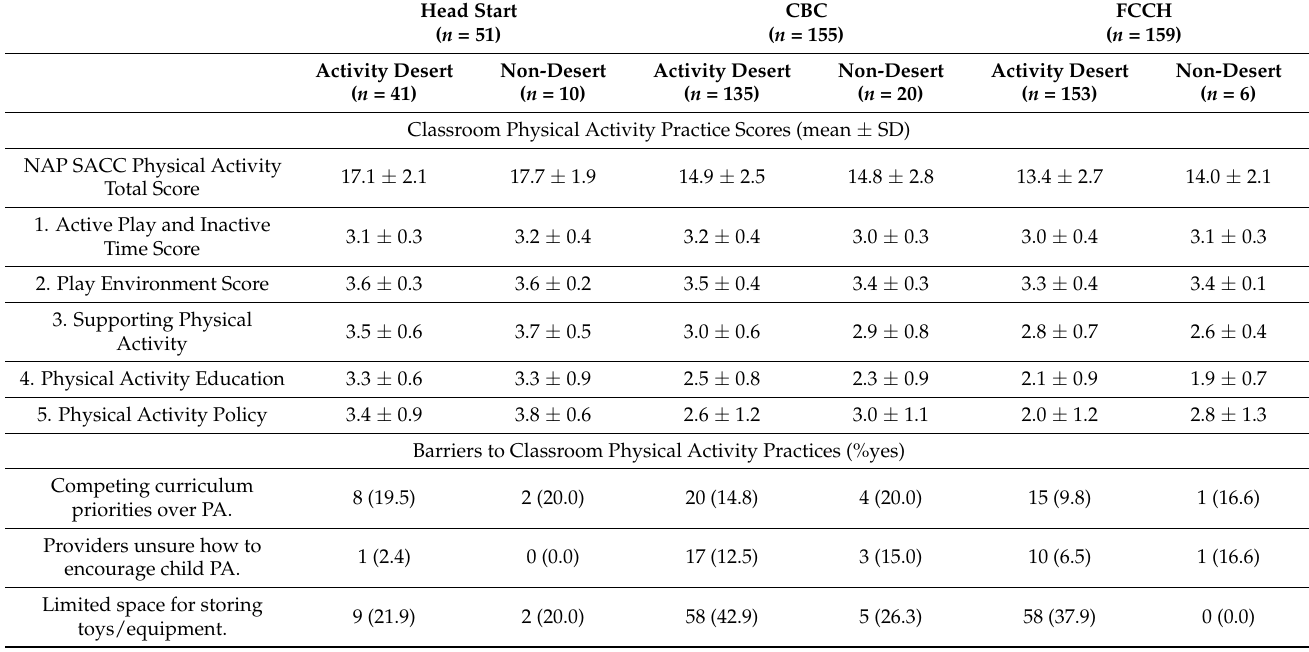
Table 4. Differences in classroom physical activity practice scores and barriers based on Activity Desert status among Oklahoma ECE programs participating in the Communities and Classroom Health Survey in 2019/2020, by childcare